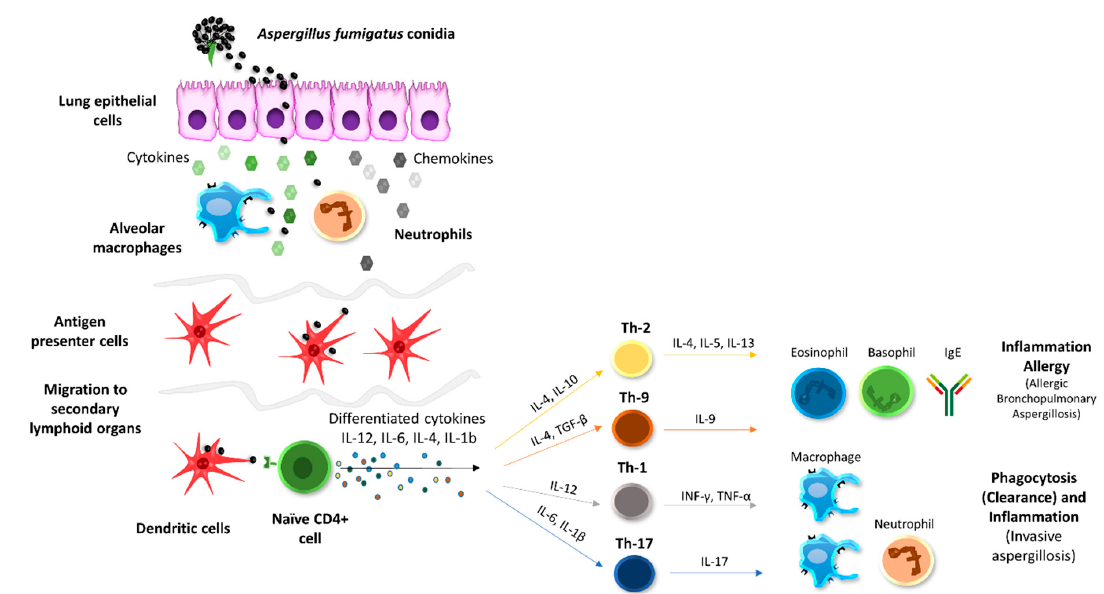
Figure 6. Schematic representation of immunological response against A. fumigatus antigens and production of differentiated cytokines and effector T H -cells (adapted and modified from [45]).